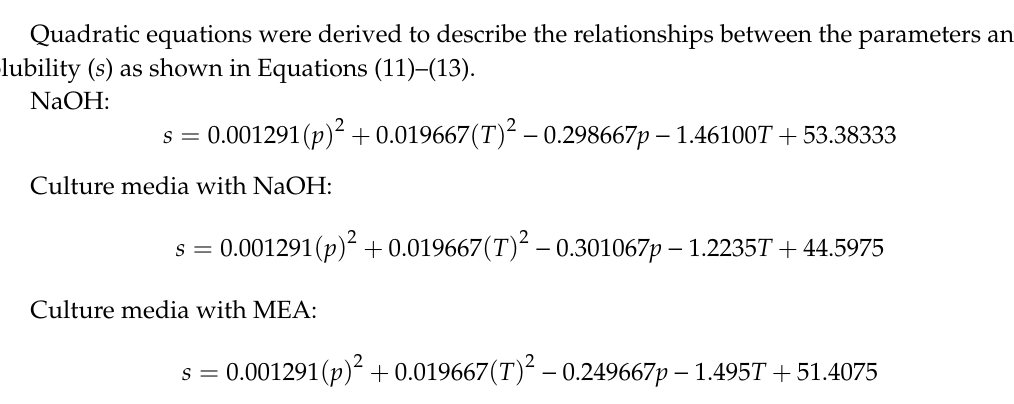
Quadratic equations were derived to describe the relationships between the parameters and CO 2